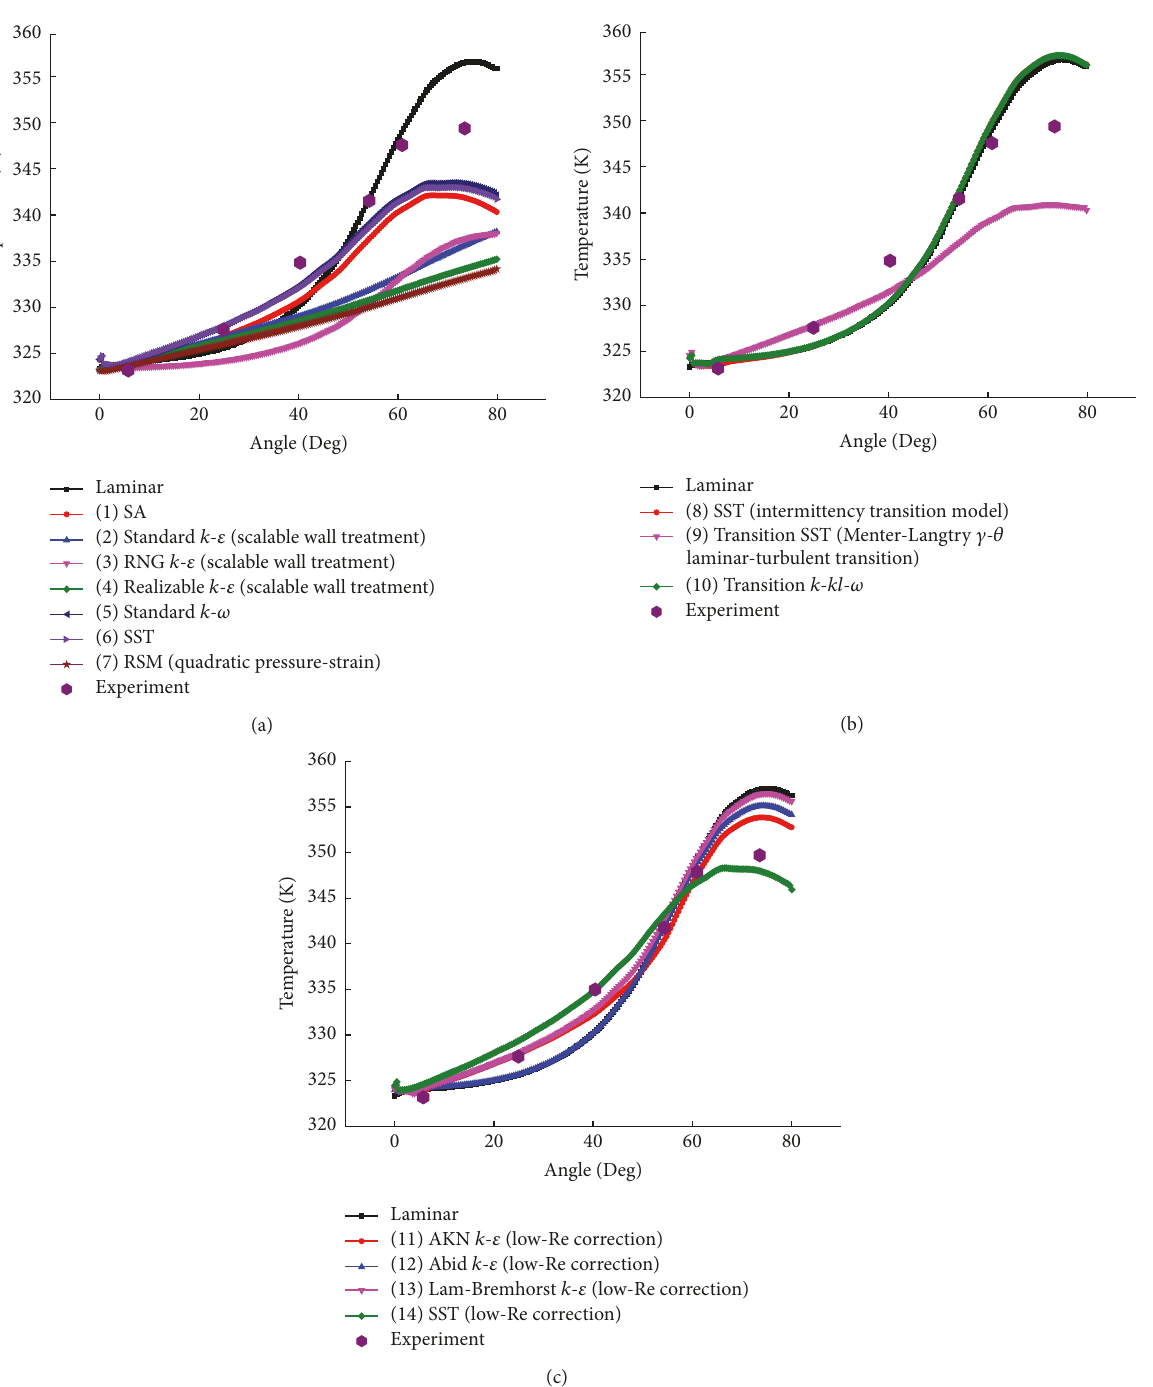
Figure 6: Comparison between the experimental temperature profile at 3000 rpm and under 180 kN and simulated temperature profile with the fixed film geometry in pad-side center line for (a) the group of the classical turbulence models; (b) the group of the transition turbulence models; and (c) the group of the turbulence models with low-Re